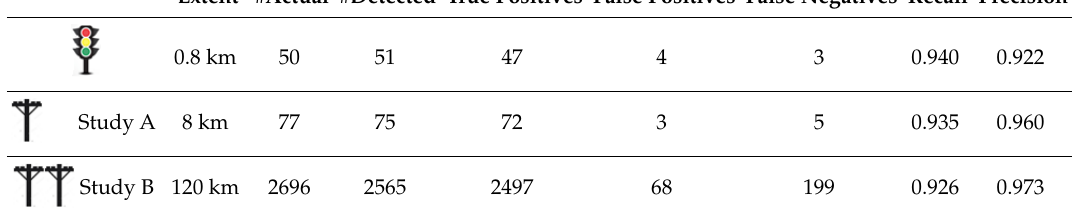
Table 1. Instance-level object discovery results for traffic lights and telegraph poles in the test